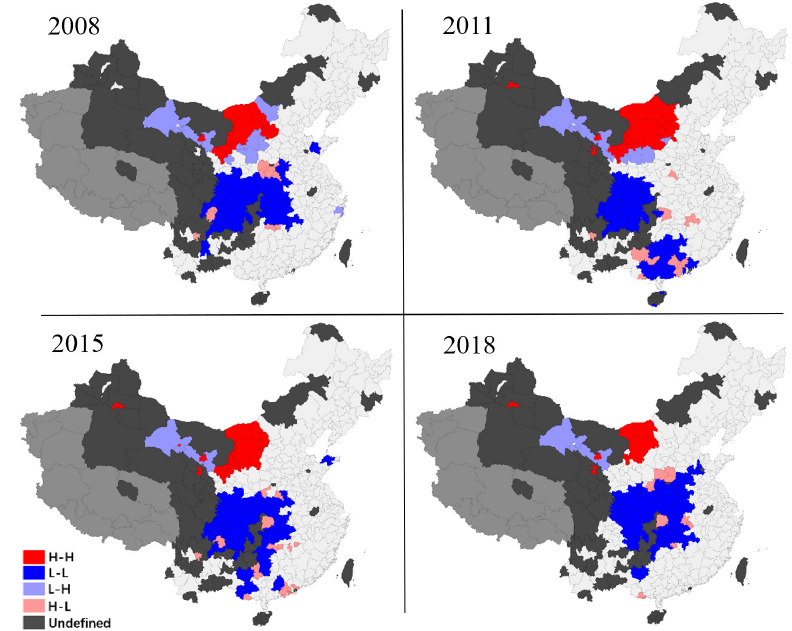
Figure 7. Regional Evolution of spatial patterns of environmental